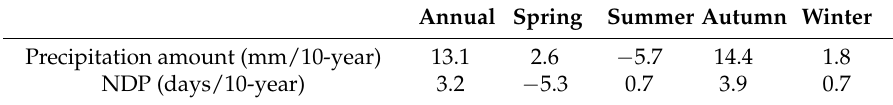
Table 2. The linear trend of precipitation amount and number of days with precipitation (NDP) for each season from 1984 to 2014.